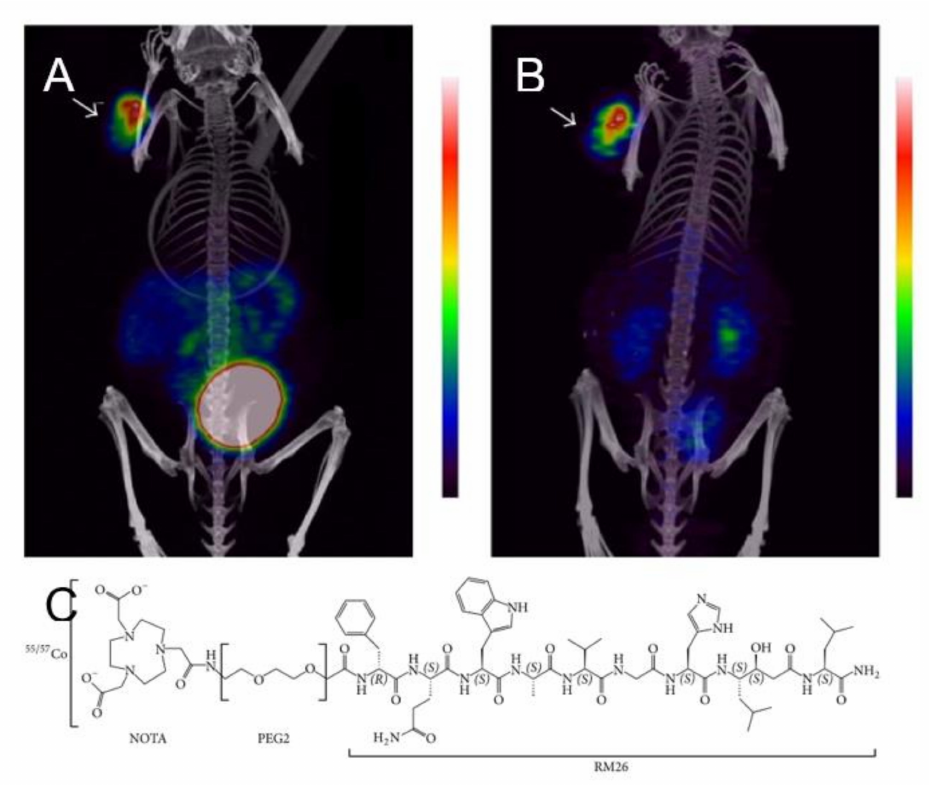
Figure 20. PET/CT images of [ 55 Co]Co-NOTA-PEG 2 -RM26 ( C ) at 3 h PI ( A ) and 24 h PI ( B ) show the reduction in background signal between early and late timepoint imaging.